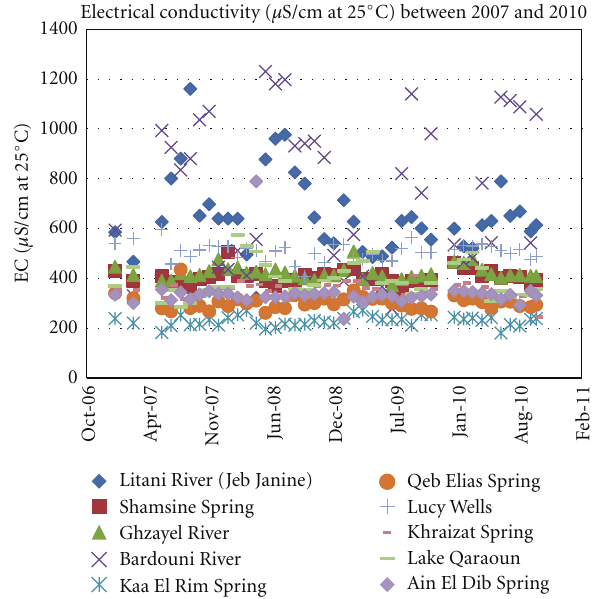
Figure 3: Recorded pH levels for years 2007 through 2010.